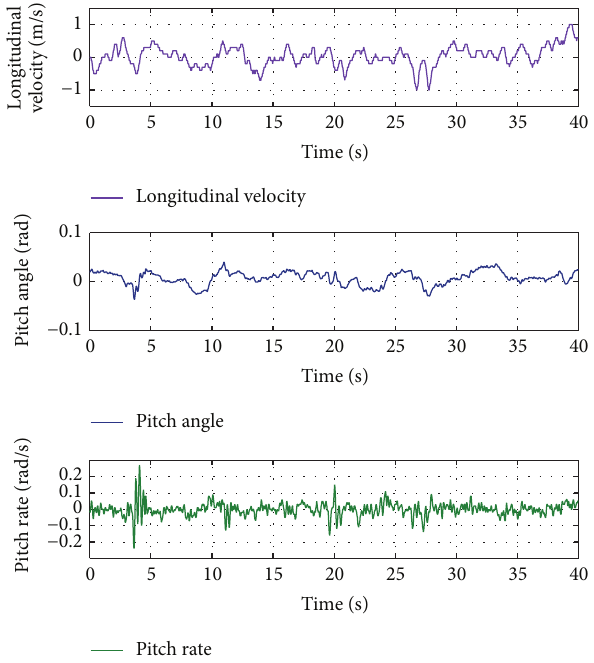
Figure 10: The longitudinal output of actual